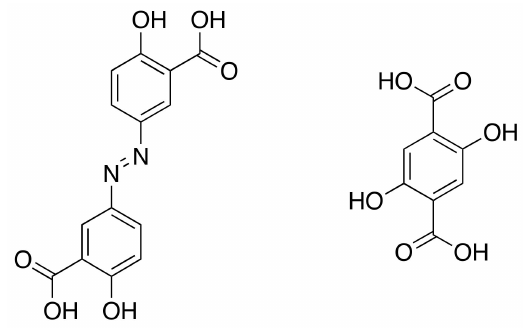
Figure 10. Olsalazine (left) and dobdc.